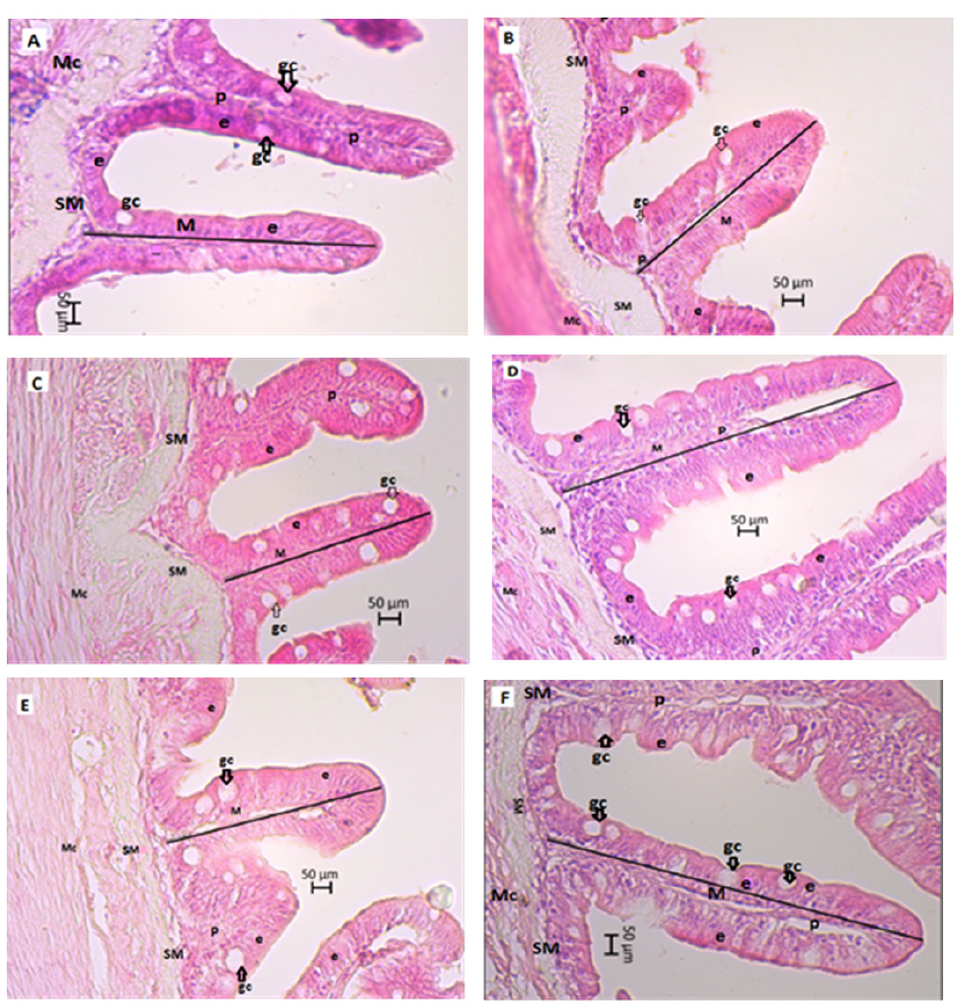
Figure 2. Histological samples of giant trevally ( Caranx ignobilis ) intestinal villi. ( A ) Feed without added activated charcoal (control). ( B ) Feed with 1% rice husk activated charcoal. ( C ) Feed with 1.5% rice husk activated charcoal. ( D ) Feed with 2% rice husk activated charcoal. ( E ) Feed with 2.5% rice husk activated charcoal. ( F ) Feed with 3% rice husk activated charcoal. M, Tunica mucosa; SM, tunica submucosa; Mc, tunica muscularis; S, serous tunica; e, epithelial lamina; p, lamina propria; gc, goblet